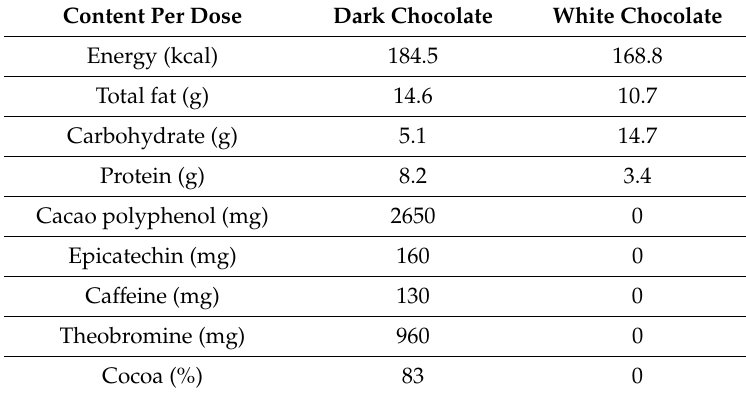
Table 2. Energy and nutrient composition of both dark and white chocolate supplements. Content Per